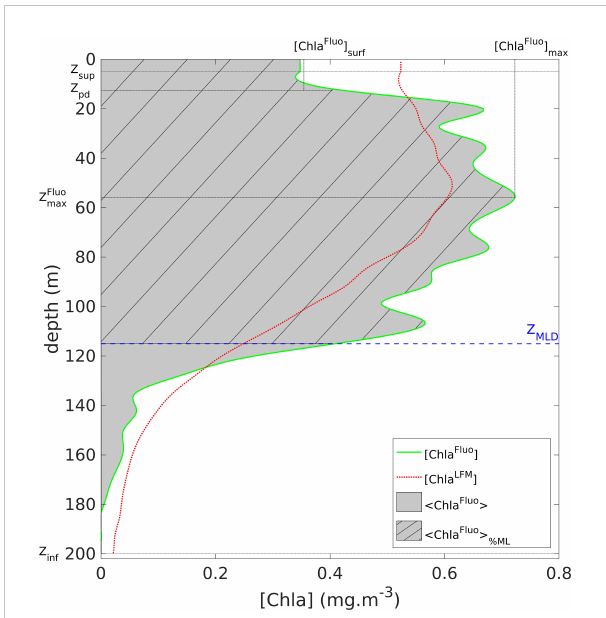
FIGURE 2 Graphical representation of the metrics de fi ned on a vertical pro fi le of [Chla Fluo ]: <Chla Fluo >, [Chla Fluo ] max , Z Fluo max , [Chla Fluo ] surf (see Section 2.2.3). The solid green line represents the [Chla Fluo ] data (for detailed information about the Fluo data processing, see Section 2.2.3 and supplementary material, Text S2 and Figure S2). The gray area represents <Chla Fluo >, the vertically-integrated amount of Chla. The dashed blue line represents Z MLD . The dashed area materializes <Chla Fluo > %ML , the proportion of <Chla Fluo > located above Z MLD . The red dotted line represents the corresponding predicted [Chla LFM ] pro fi le (see Section 2.5). When necessary, the metrics were identically computed on the vertical pro fi les of [F Fluo ], [F], [F LFM ] and [Chla LFM